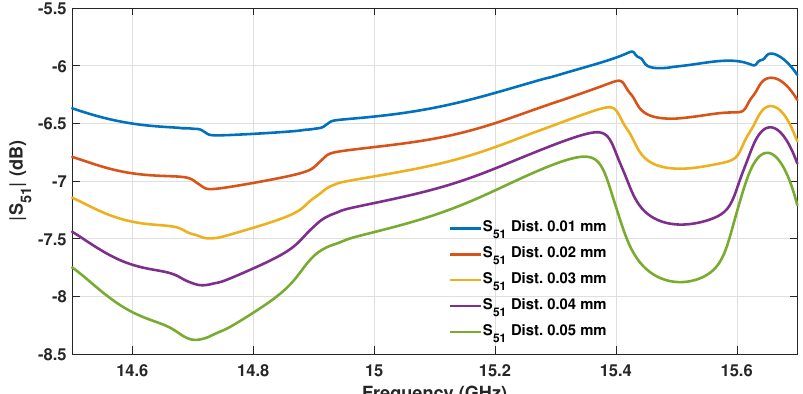
Figure 8. Simulation results of coupling S 5,1 varying the gap between the lid and the main body in steps of 0.01